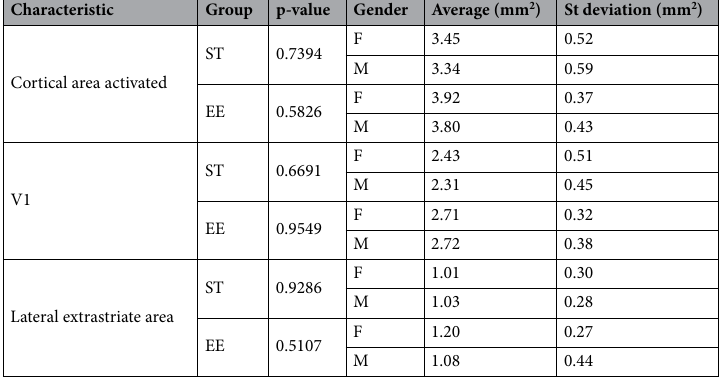
Table 1. Gender specific values for cortical area activated through retinotopic mapping show no difference.